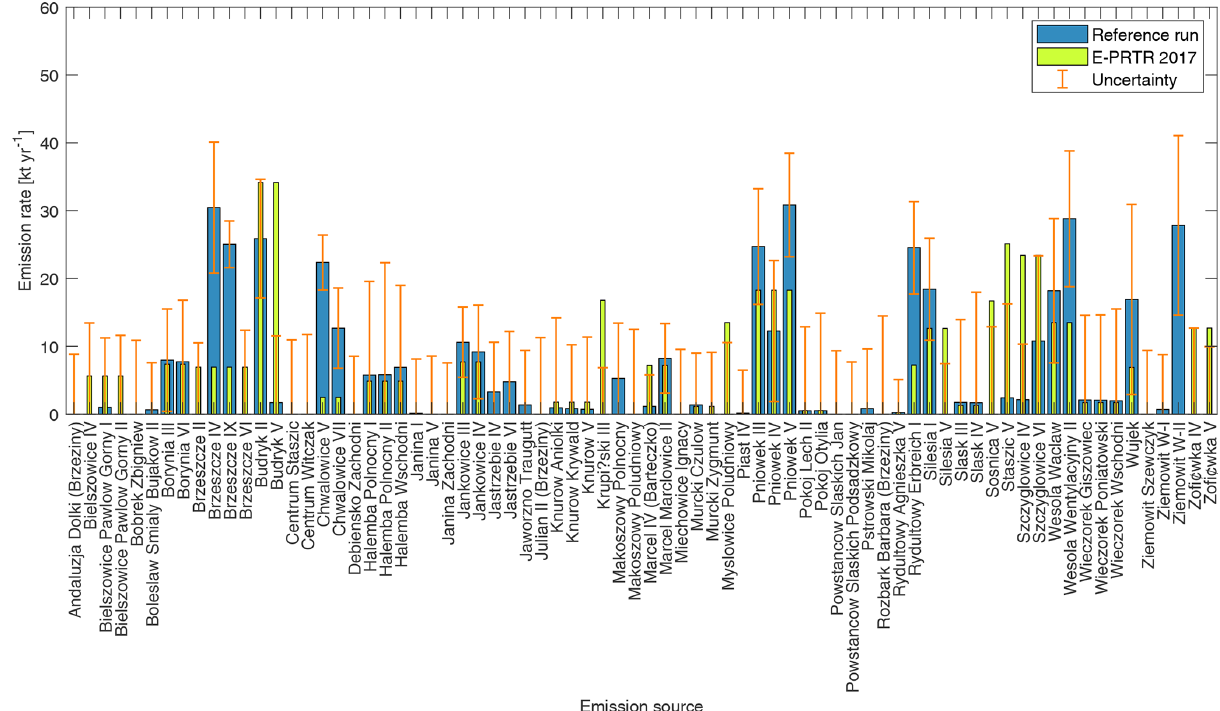
Figure 11. Emission estimates (cid:56) i (blue bars) in ktyr − 1 for 74 individual mining shafts using the morning and afternoon flight of 6 June 2018. Slim green bars are the reported yearly average values for each mining company (E-PRTR 2017) evenly distributed among the respective ventilation shafts. The orange error bars stem from the quadrature sum of the statistical uncertainties (cid:15) i (computed from the parameter covariance matrix ˆ S ) and the uncertainties σ ensemble derived from a variational ensemble with systematically perturbed parameters.